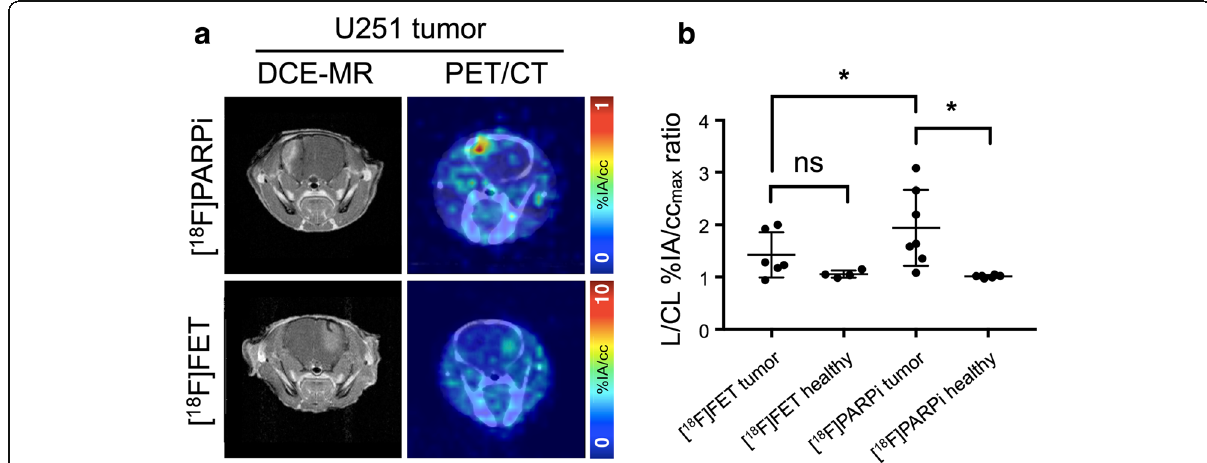
Fig. 5 PET imaging of mice with focal intracranial U251 cell xenografts. a (left column) DCE-MR and (right column) fused PET/CT transaxial slices of mice with U251 tumor, injected with (top row) [ 18 F]PARPi and (bottom row) [ 18 F]FET. b Lesioned-to-contralateral hemisphere %IA/cc max ratios for mice in different groups. *Significant at p <